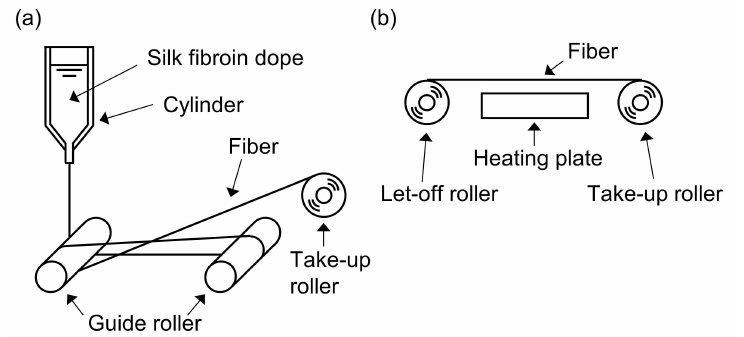
Figure 1. Conceptual images of dry spinning and heat stretching for regenerated silk fibroin. ( a ) Dry spinning system. The extruded dope solution was dried in ambient air to mold into the fiber on the guide rollers equipped with polytetrafluoroethylene tubes to prevent sticking of the dope in process and collected to the take-up roller. ( b ) Heat stretching system. The molded silk fiber was sent from the let-off roller and collected to the take-up roller directly. Spinning fiber was heated for 3 mm tolerance over the heating plate and stretched among the two